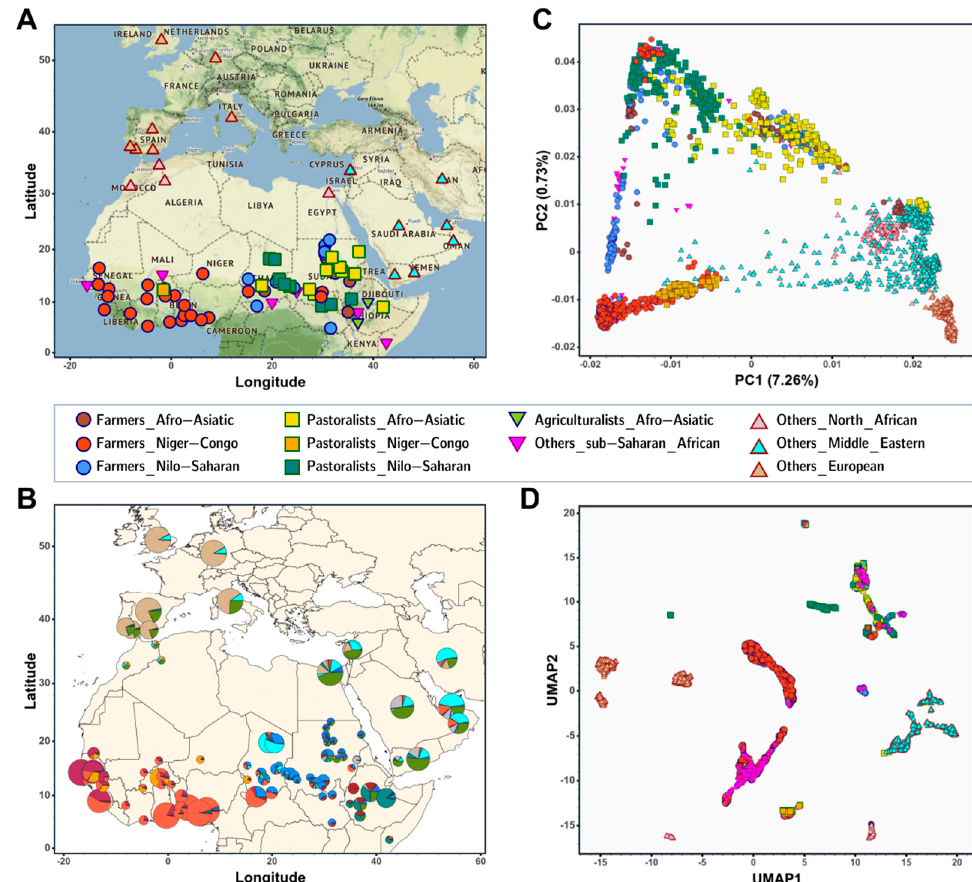
Figure 4. Patterns of admixture and population structure across the Sahel belt. ( A ) Geographic locations of populations included in the dataset (analysed were 3,245 individuals from 89 popula- tions worldwide and 179,182 autosomal SNPs). This dataset was assembled after merging publicly available genome-wide SNP datasets [58,59,62–67] (further details have been presented previously; see supplementary Table S2 in [59]). ( B ) Genetic cluster membership estimated using unsupervised clustering ADMIXTURE analysis [60] at K = 12. The size of the pie charts is in relation to the sample size of each studied population and each colour shows the proportion of each estimated component. ( C ) Principal component analysis (PCA) for all studied populations estimated using the smartPCA [68]. ( D ) PCA-UMAP plot [61] combining the first five PCs estimated in the PCA. This figure highlights populations with different lifestyles (farmers by circles, pastoralists by squares, agriculturalists and other sub-Saharan African populations by inverted triangles, and other groups by triangles), speaking different African languages (Afro-Asiatic speakers in brown, yellow or green, Niger-Congo speakers in red or orange, and Nilo-Saharan speakers in blue or teal), or have different geographical distributions. For better visualisation, interactive figures were included and are available at https://github.com/cesarforteslima/Sahel-review, accessed on 20 January 2023.